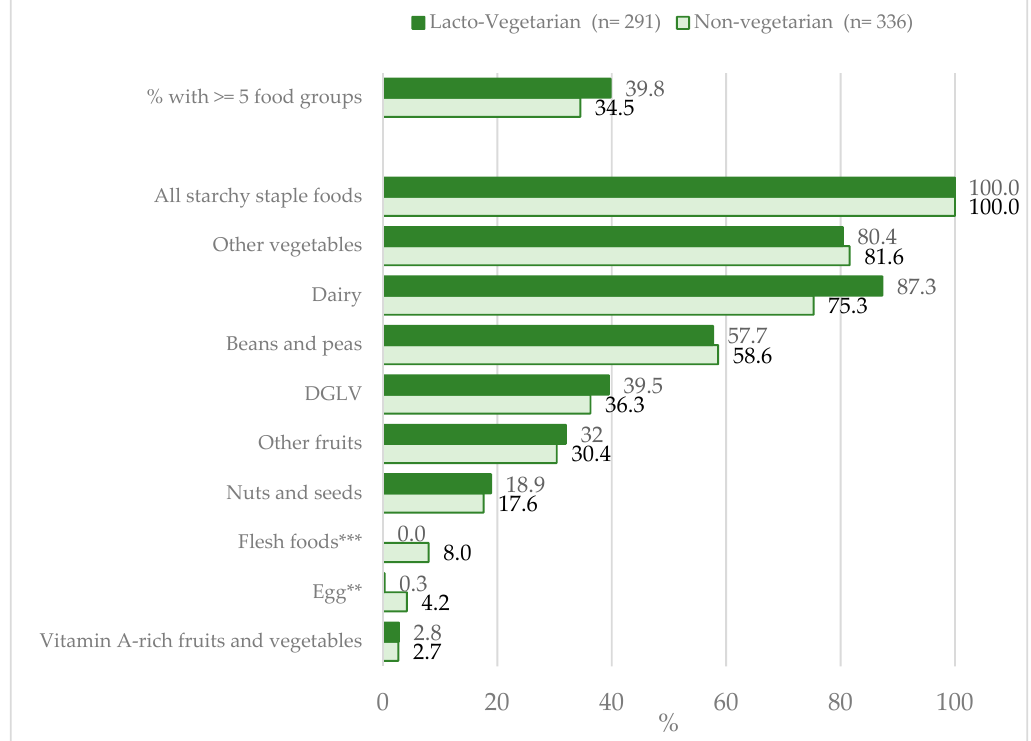
Figure 2. Food group consumption in the previous 24 h among lacto-vegetarian and non-vegetarian pregnant women. DGLV: Dark Leafy Green Vegetables; flesh foods: meat, poultry, and fish. ** p < 0.01, *** p < 0.001.